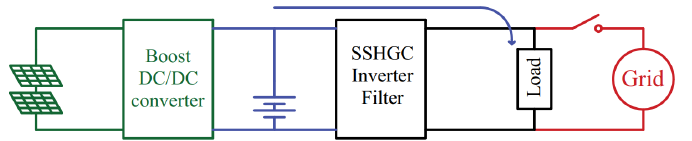
Figure 5. Power operation mode